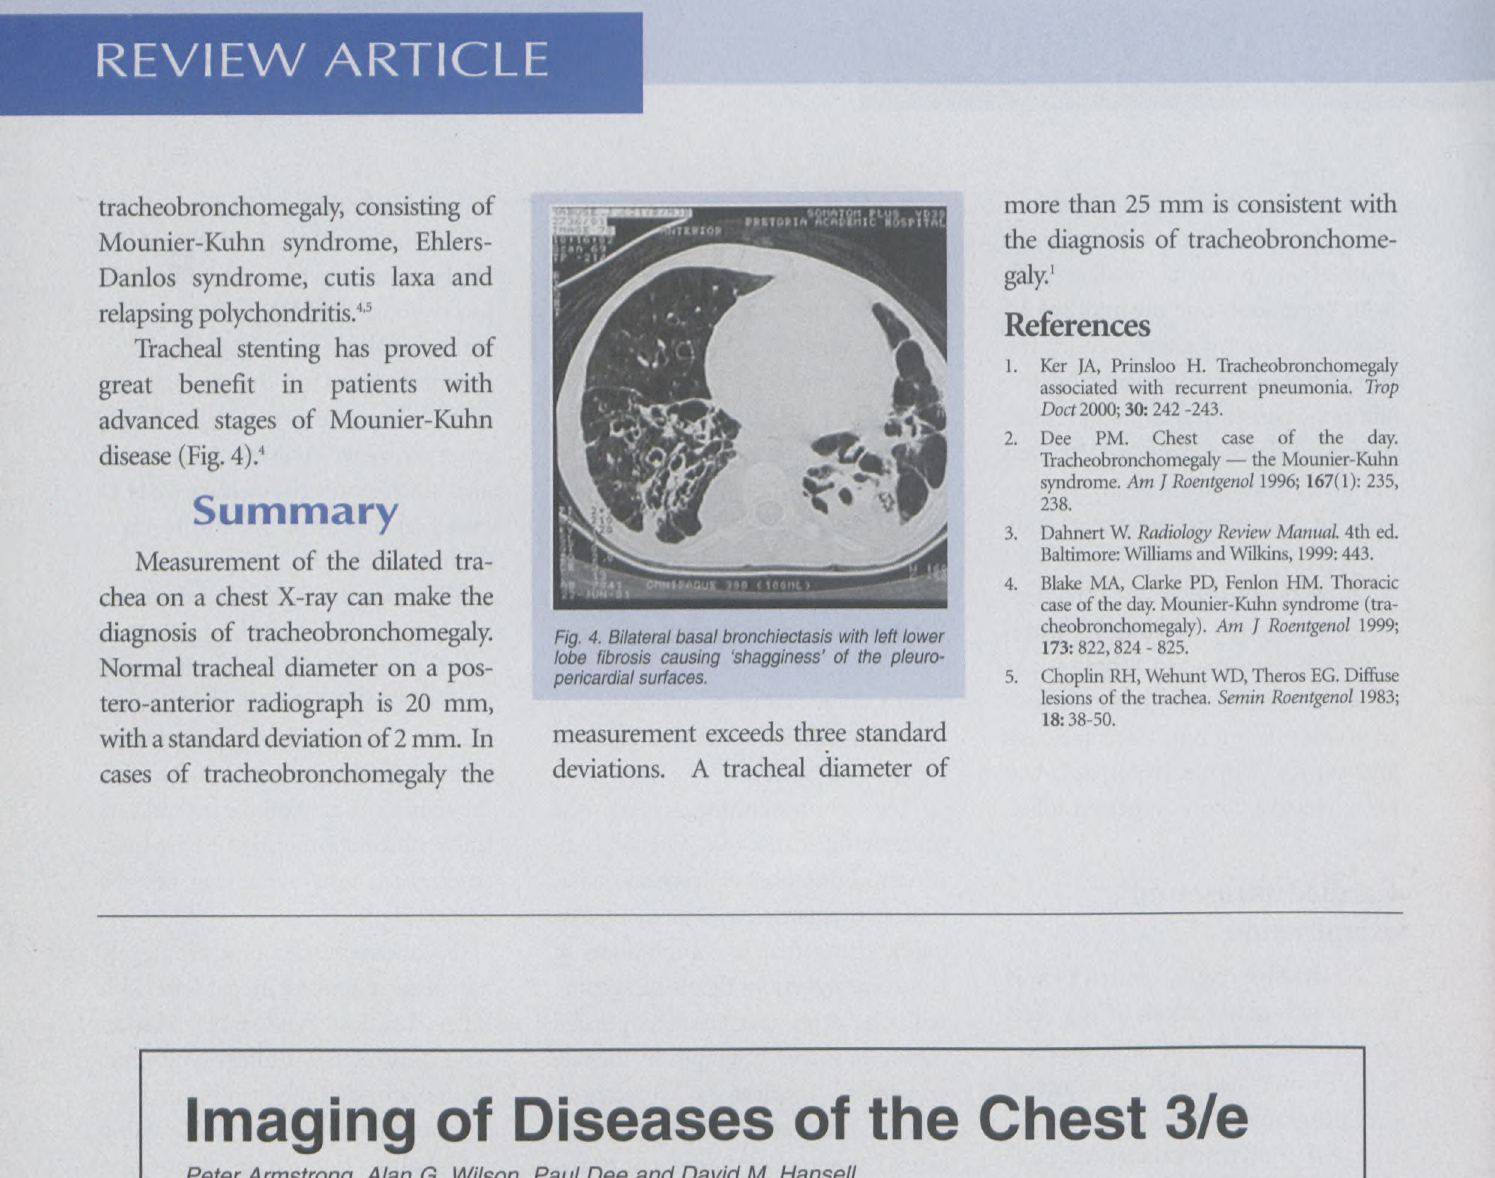
Fig. 4. Bilateral basal bronchiectasis with left lower lobe fibrosis causing 'shagginess' of the pleuro- pericardial